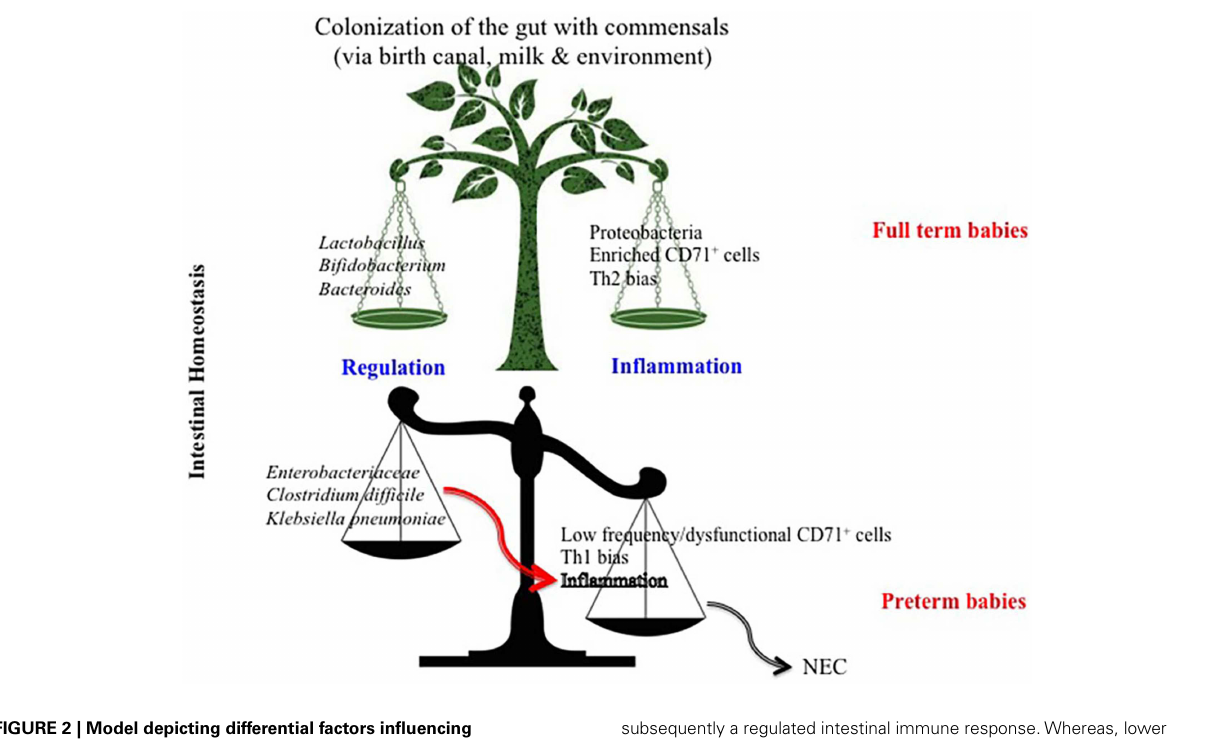
FIGURE 2 | Model depicting differential factors influencing intestinal homeostasis in full term versus preterm newborns . High proportion of CD71 + erythroid cells in full term infants skews their immune response toward aTh2 phenotype which influences the bacterial composition to a diverse commensal colonization and